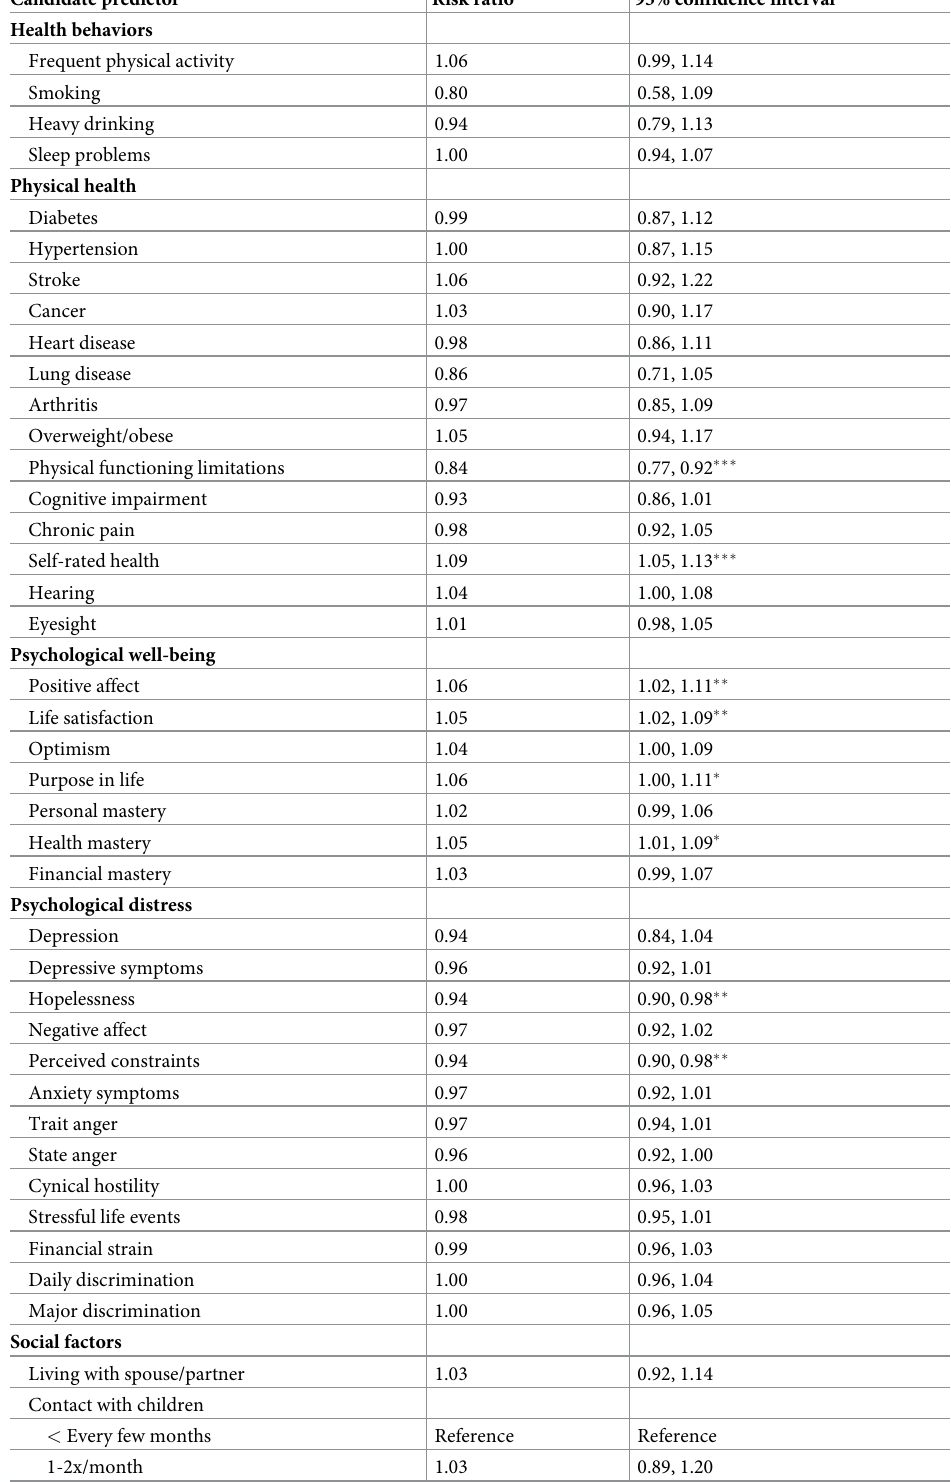
Table 2. Candidate predictors (T 1 ) of subsequent religious service attendance (T 2 ) a,b,c